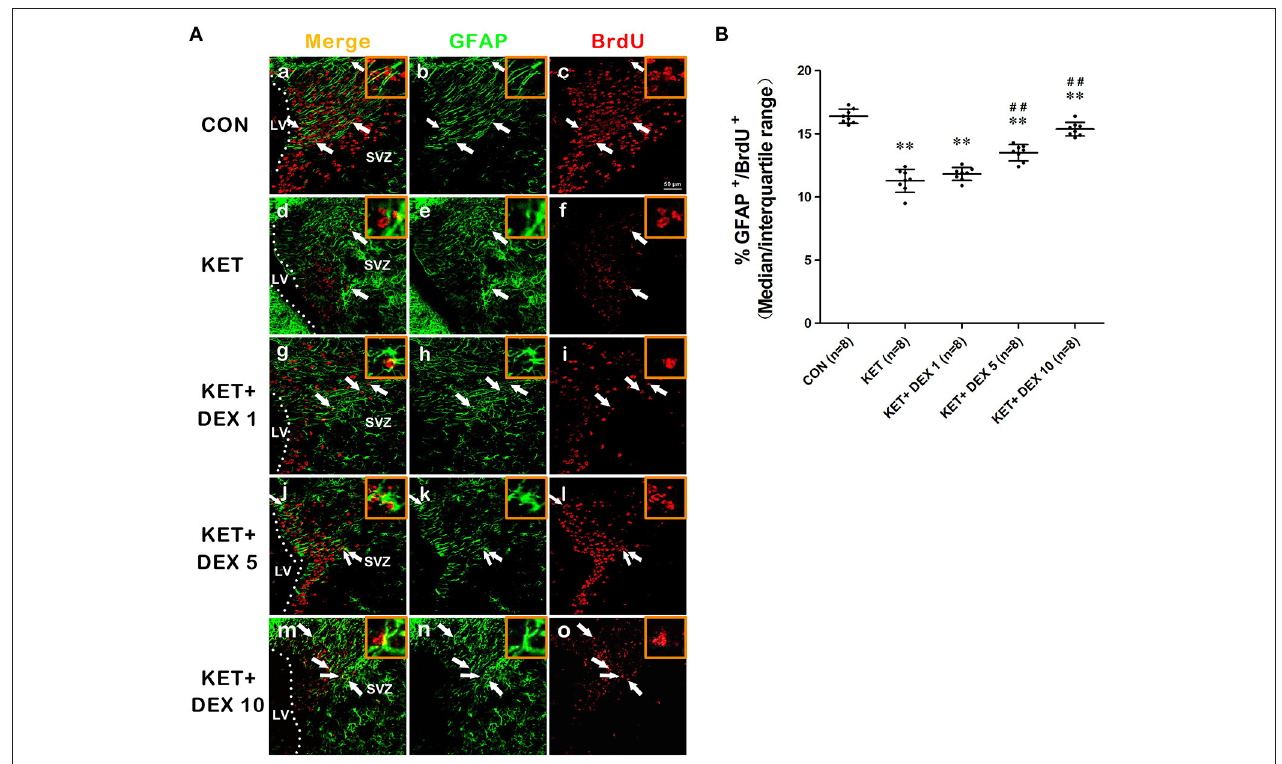
FIGURE 3 | The effects of ketamine (KET) and dexmedetomidine (DEX) on the astrocytic differentiation of neural stem cells (NSCs) in the SVZ. Neonatal rats were pretreated with different doses of DEX via intraperitoneal injection prior to ketamine anesthesia for 30min. (A) Representative images of astrocytic differentiation (BrdU, red; GFAP, green) were captured using a laser scanning confocal microscope (magnification × 400, scale bar: 50 µ m). A portion of BrdU postive cells expressed GFAP in the cytoplasm. The GFAP + /BrdU + cells implies that BrdU and GFAP form close appositions, but they are not co-located. The arrows point to postively labeled cells. (B) The proportion of GFAP + /BrdU + cells per SVZ in the different groups is shown. Data are presented as the means ± SD (eight tissue sections per group). ** p < 0.01 compared with the Control group; ## p < 0.01 compared with the KET group. SVZ, subventricular zone; LV, lateral